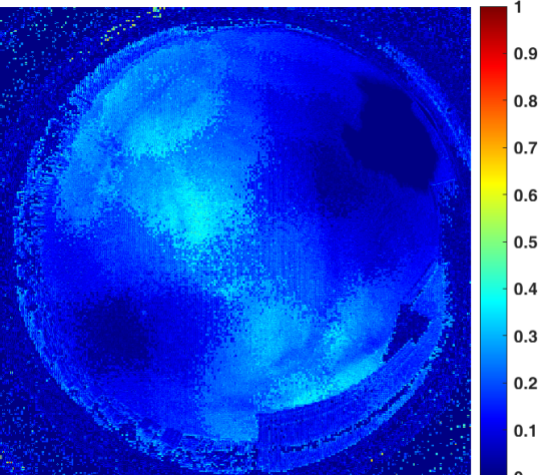
Figure 14. The results of the polarization distribution of a clear sky. The original image acquired by the polarization camera is saved in .jpeg format. Due to image compression, there is a significant error in the distribution result of the sky polarization degree.